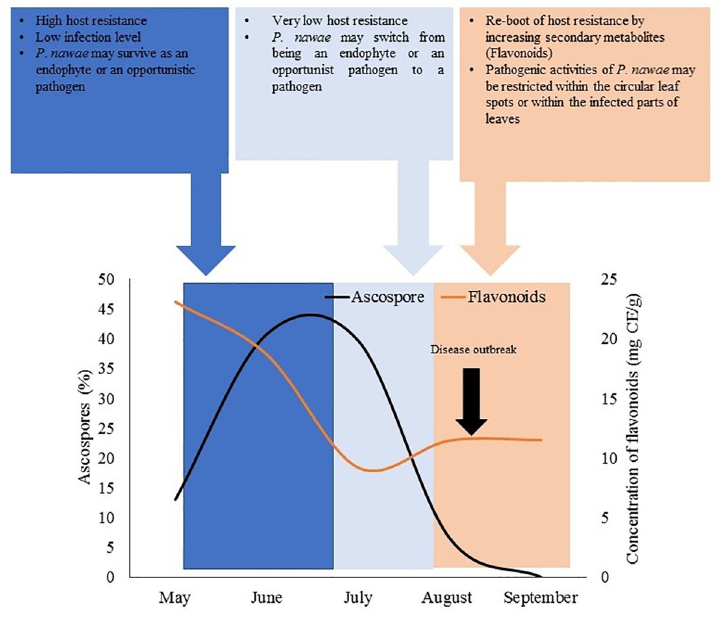
Fig 7. Hypothetical relationship between P . nawae infection and flavonoid content of persimmon. The trend line for ascospore dynamics is adopted from Hassan et al. [7]. The trend line for flavonoid content in persimmon leaf extracts is acquired from Jung and Jeong